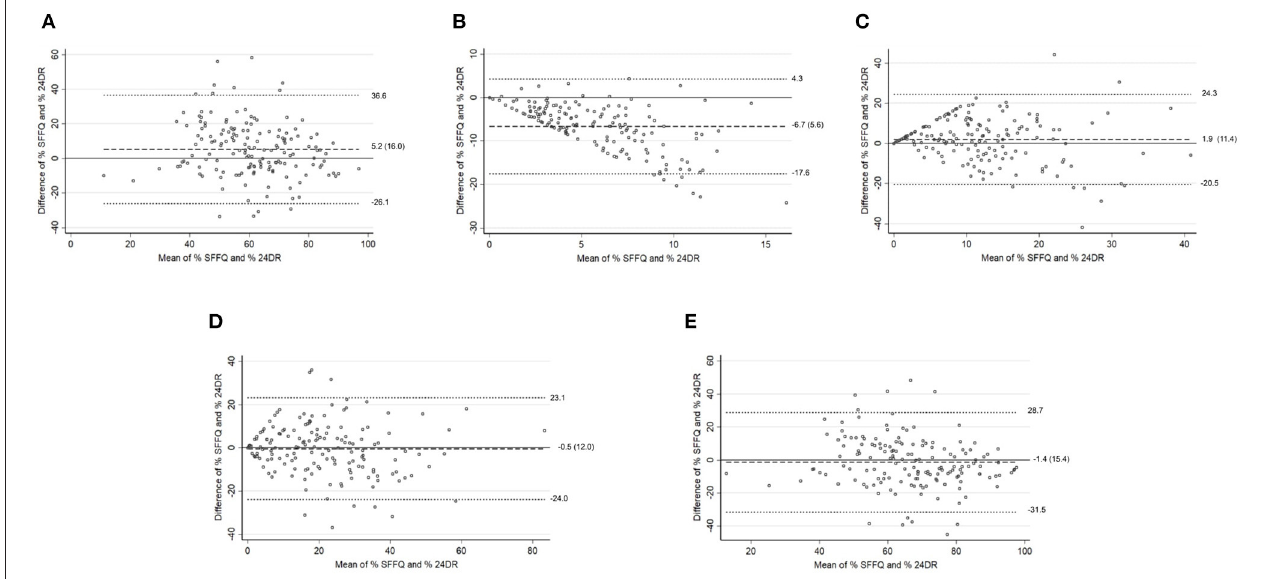
FIGURE 2 | Adults ( < 60 y). Bland–Altman plots for % energy intake between the SFFQ and 24DRs: (A) Unprocessed and minimally processed foods group. (B) Processed culinary ingredients group. (C) Processed foods group. (D) Ultra-processed foods group. (E) Unprocessed and minimally processed foods group and processed culinary ingredients group. Dotted lines represent 95% limits of agreement. Dashed line represents difference of mean.